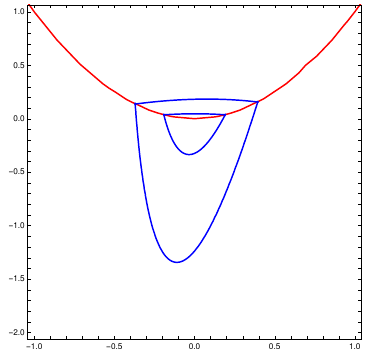
Figure 1. Two crossing limit cycles of planar discontinuous piecewise linear Hamiltonian systems (PHS) intersecting the parabola at two points.